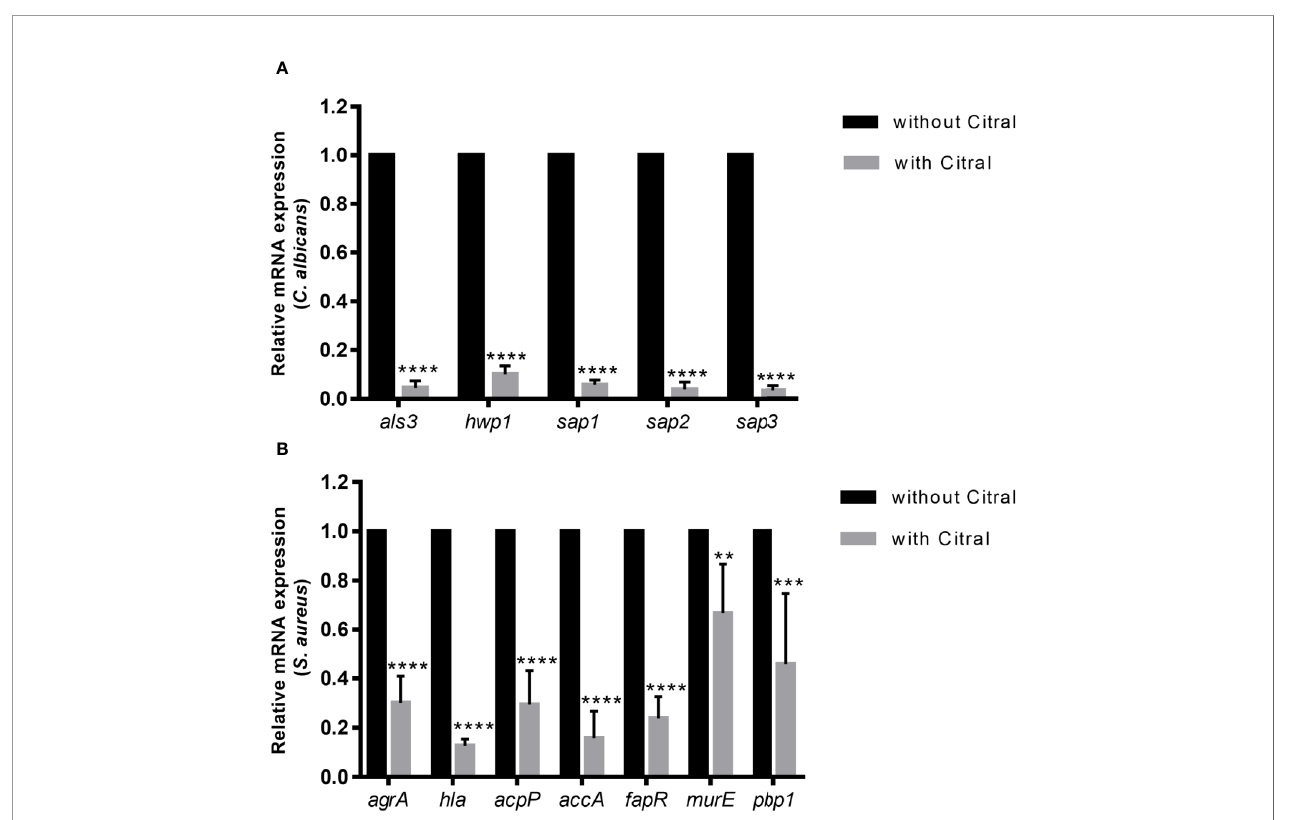
FIGURE 8 | The expression pro fi les of related genes of each species in dual-species bio fi lms after 24 h exposure to 0.5% citral. (A) Expression levels of als3 , hwp1 , sap1 , sap2 , and sap3 in C. albicans . (B) Expression levels of agrA , hla , acpP , accA , fapR , murE , and pbp1 in S. aureus . The untreated bio fi lm was set as control.18s rRNA gene was used as internal control for C. albicans and 16s rRNA gene was used as internal control for S. aureus . Data are shown as mean ± SD (n=3), **p < 0.01, ***p < 0.001, ****p <